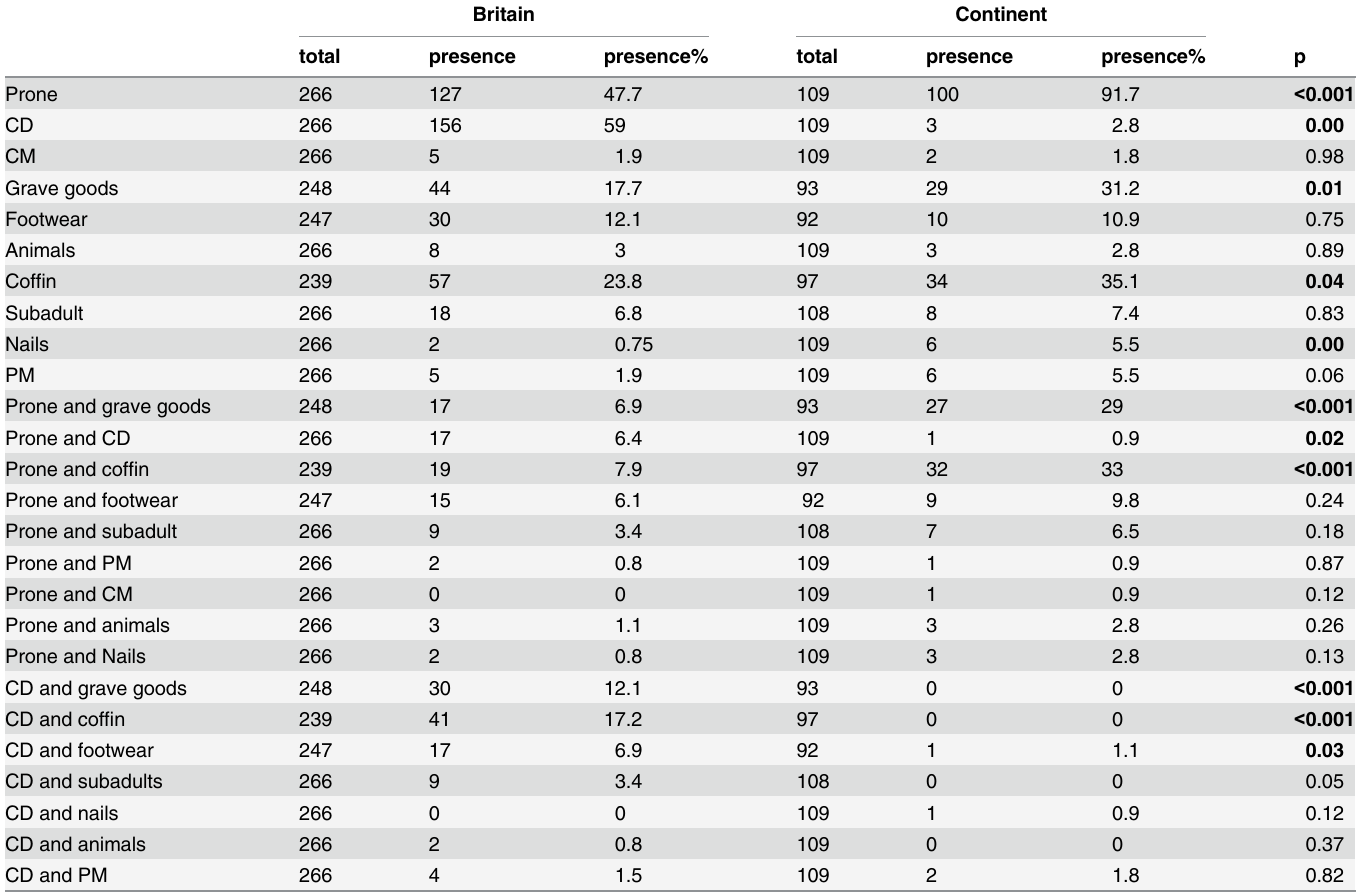
Table 2. Frequency of each variable and combined variables in Britain and Continental